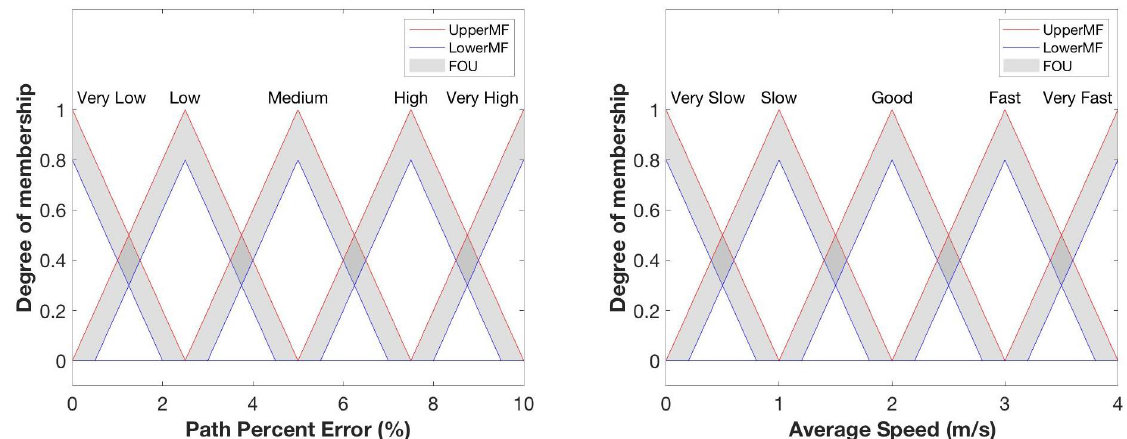
Figure 12. Membership functions for Case Study III to observe path percent error and average vehicle speed.